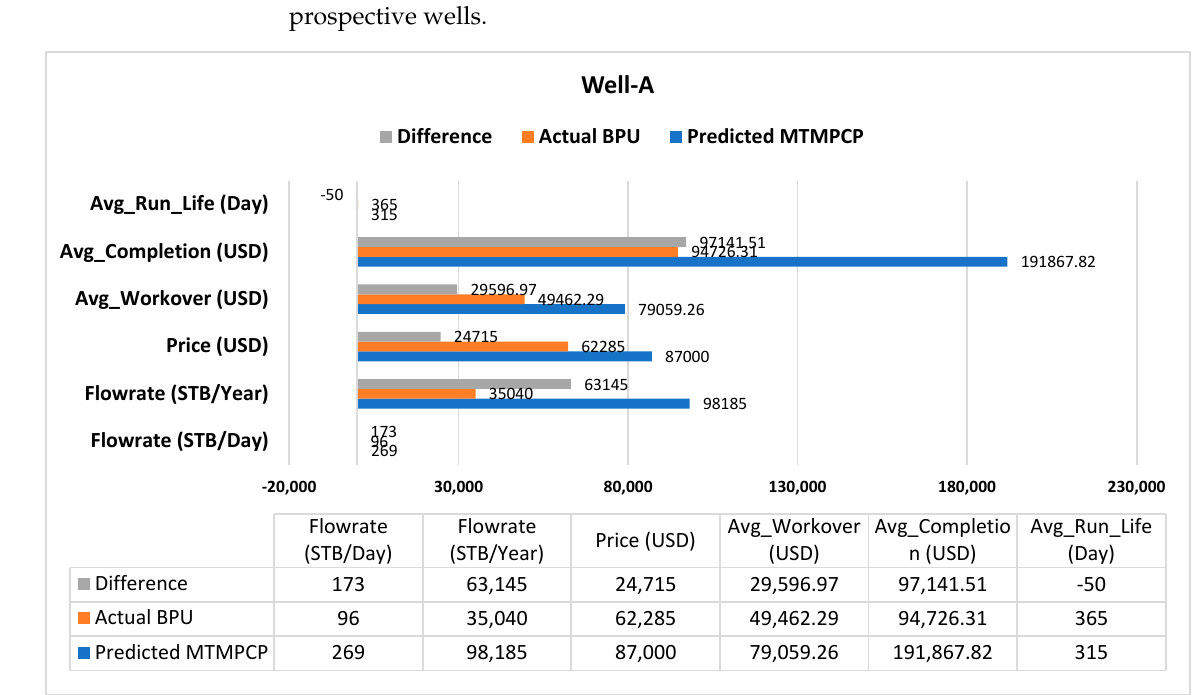
Figure 9. Well - A production and cost di ff erence of actual and predicted AL.